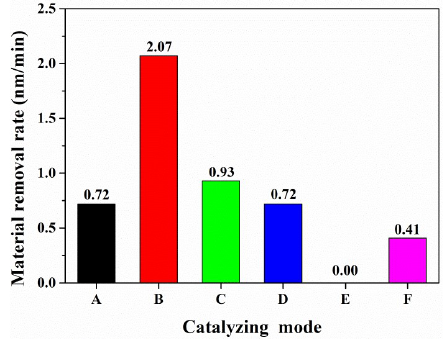
Figure 3. Material removal rate of sapphire under different catalyzing modes: ( A ) pristine pad, ( B ) synthetic soft abrasives, ( C ) citric acid, ( D ) theophylline, ( E ) green tea powder, and ( F ) coffee powder.